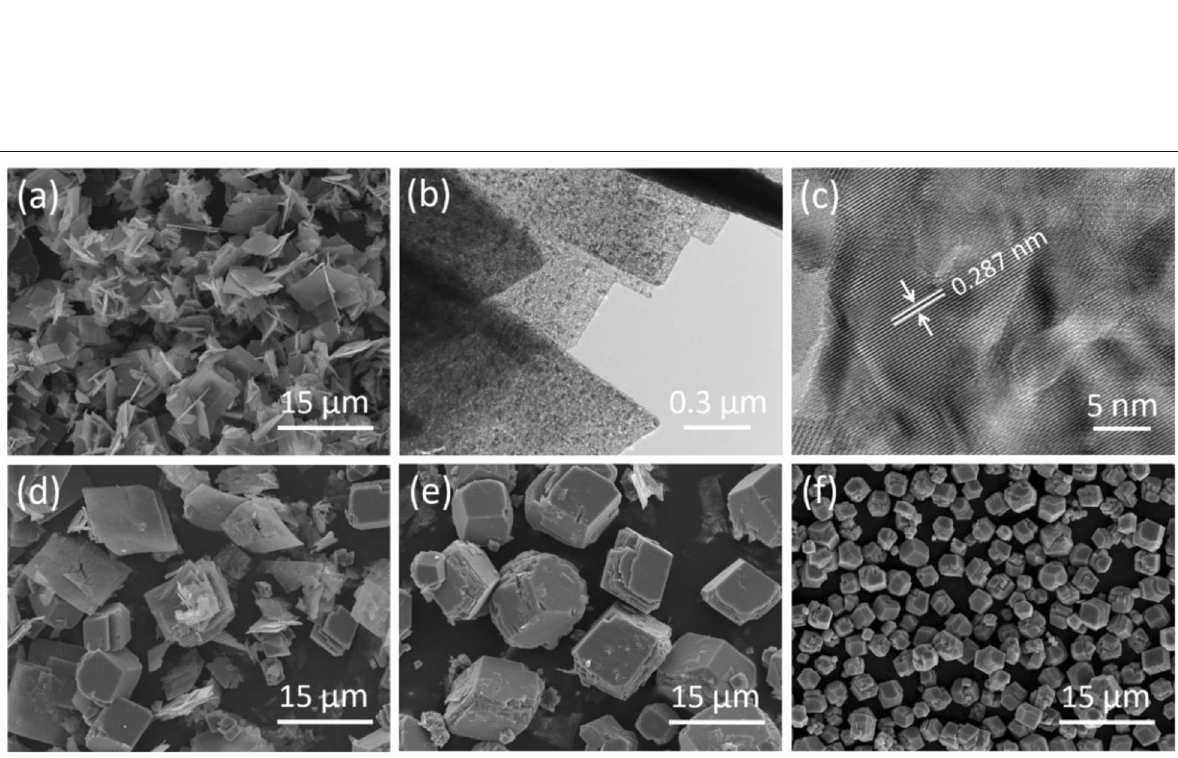
Fig. 3 a SEM image and b , c TEM images of Co 3 O 4 nanosheets obtained without any egg albumin, and the SEM images of the Co 3 O 4 samples prepared with egg albumin of d 0.5, e 1, and f 5 mL